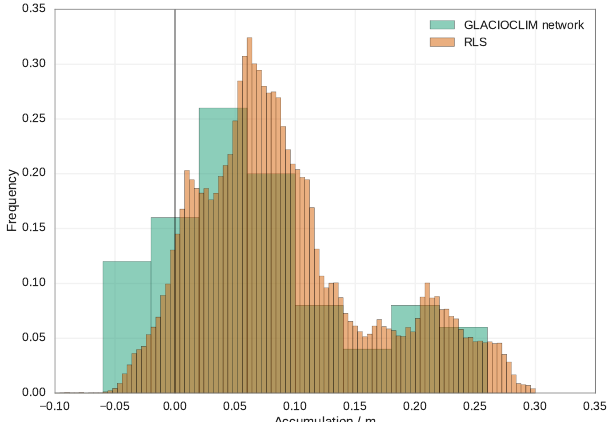
Figure 11. Distribution of the spatial variations of accumulation at Dome C observed by RLS (measured between 3 January and 5 December 2015) and the GLACIOCLIM network at 2km from Concordia station (measured between 3 January and 18 November